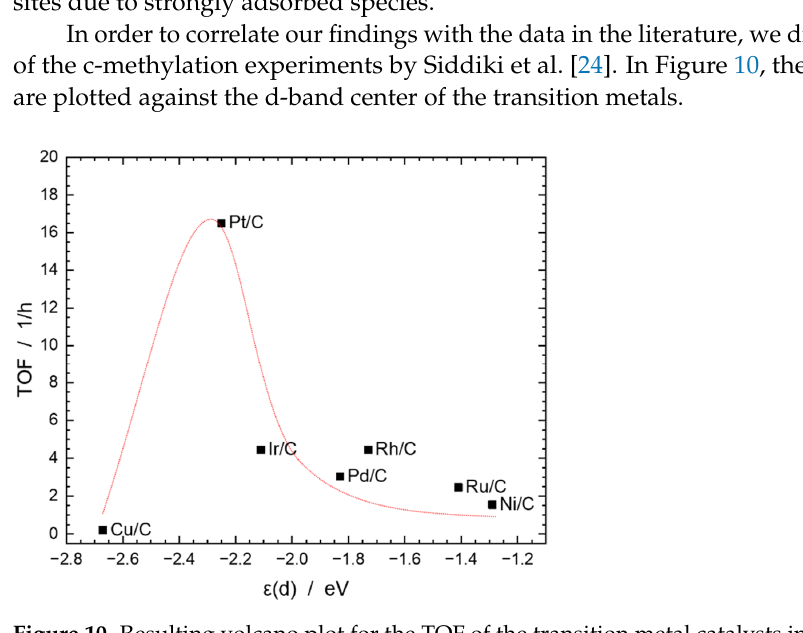
Figure 9. Resulting volcano plot for the turnover frequency (TOF) of the transition metal catalysts in the i-butanol synthesis. The red curve was drawn for the purpose of clarity.